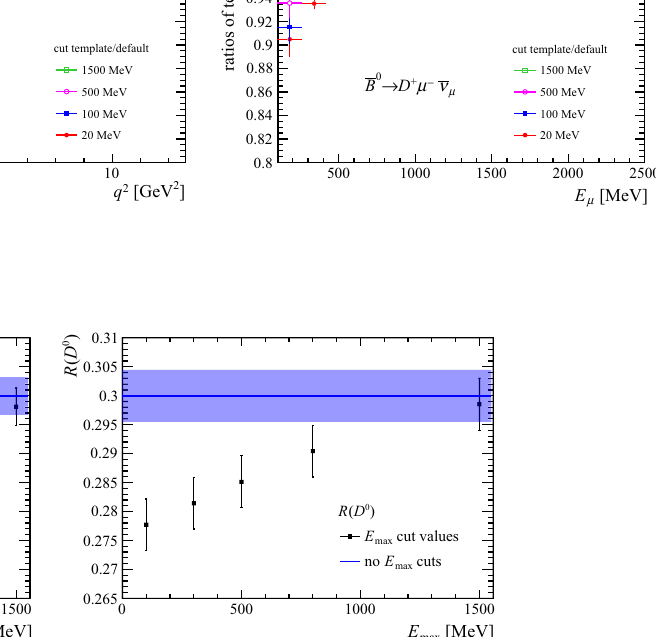
Fig. 8 Ratios of the cut q 2 (left) and E μ (right) distributions over the corresponding default distributions for B 0 → D + μ − ν μ decays, for